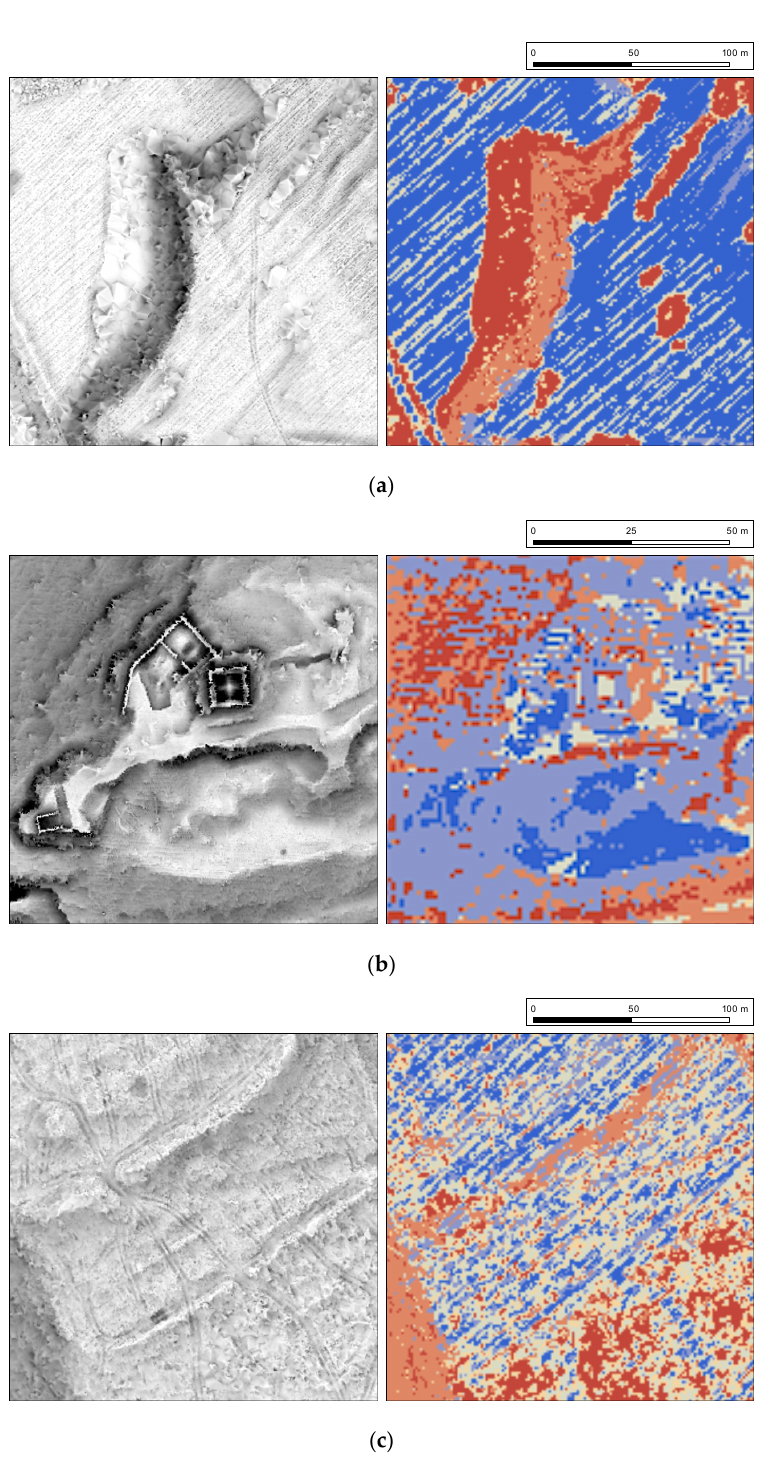
Figure 9. Visualizations of DFMs ( left ) and DFM confidence maps ( right ) for selected areas at 200% crop size. See Figure 8 for the location. The processing pipeline is the same for all instances (point cloud processing according to [1]; TLI interpolation; 0.5 m DFM resolution; sky view factor visualization with default settings in RVT v.2.2).